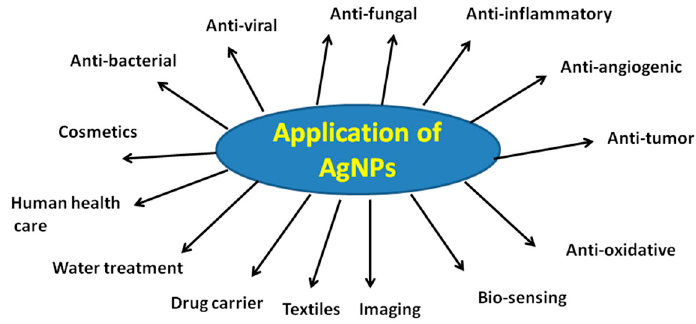
Figure 3. Various applications of AgNPs.